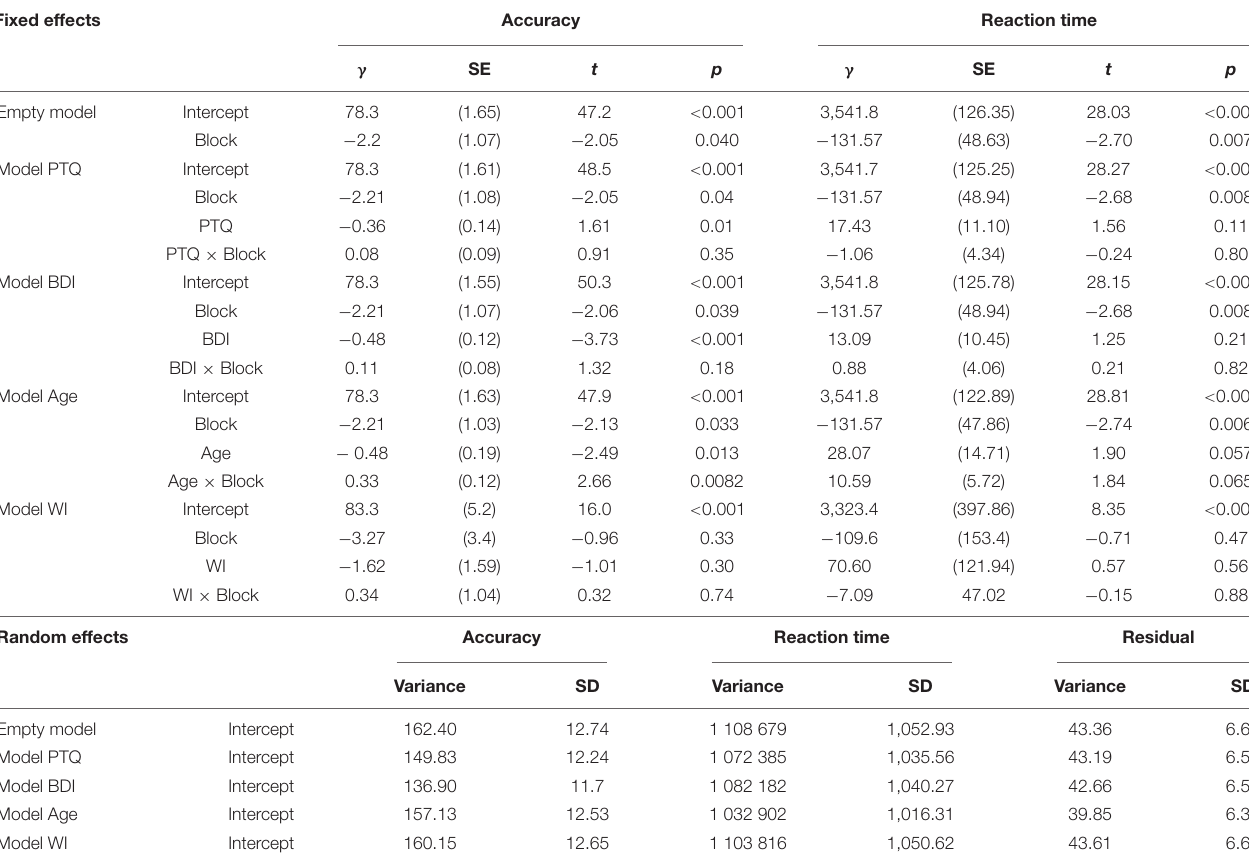
TABLE 1 | Results of the multivariate growth model with random intercepts and fixed